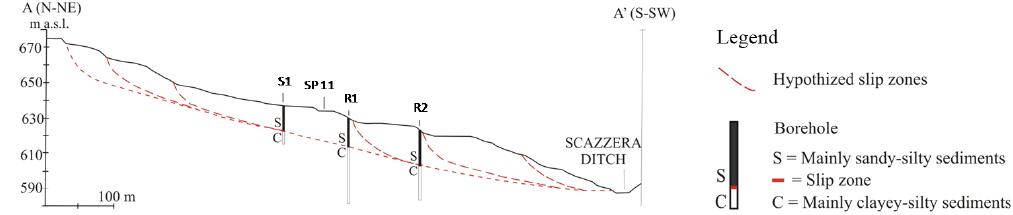
Figure 13. Geomorphological profile (outline A–A (cid:48) in Fig. 9) with the trend of the slip zones, hypothesized considering lithological infor- mation from boreholes and geomorphological interpretation of topographic